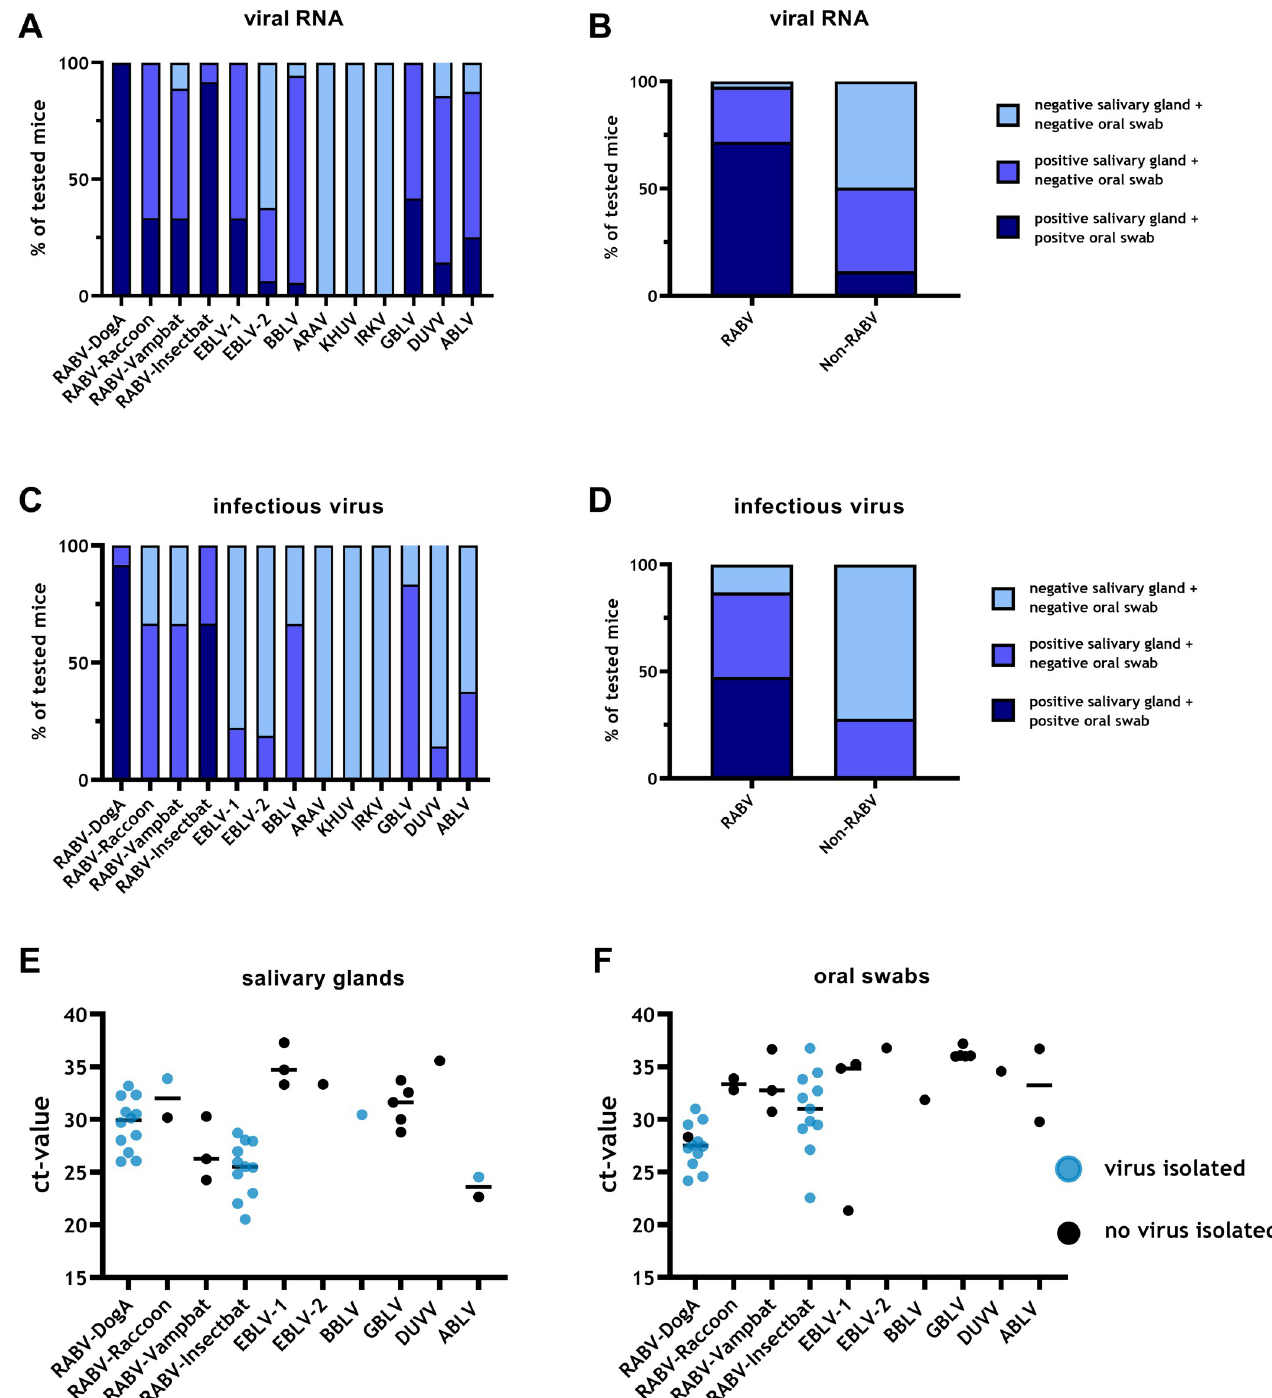
Fig 8. Comparison of virus shedding in lyssavirus-infected mice. Percentage of animals positive/negative for viral RNA (A, B) and viable virus (C, D) in either salivary glands or oral swabs or both according to individual lyssaviruses (A, C) or grouped according to RABVs and non-RABV bat lyssaviruses (B, D). Correlation between ct-values as obtained in RT-qPCR and results of virus isolation in salivary glands (E) and oral swabs (F). Here, only animals were considered were active shedding (positive salivary gland and positive corresponding oral swab) was observed. Individual ct-values are shown and the mean is indicated. Successful virus isolations in cell culture are